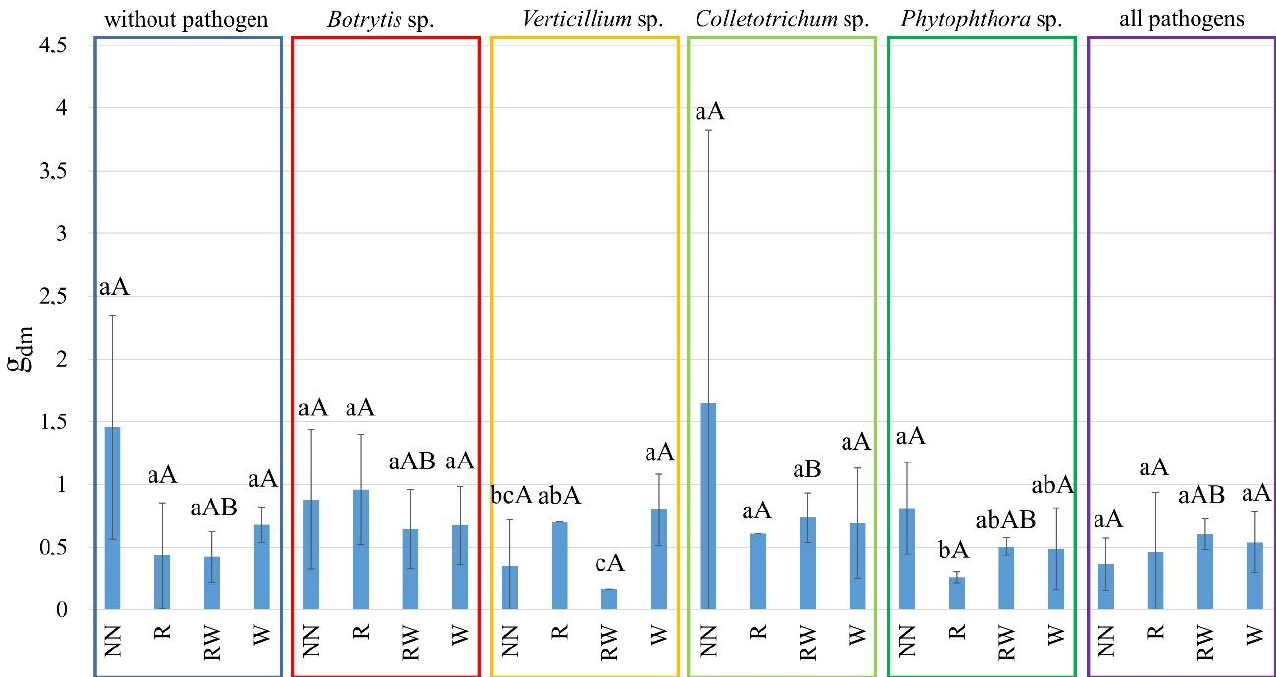
Figure 4. The early effect of the bacterial consortium on Polana raspberry plant growth in the pot experiment depended on the pathosystem and naturalization strategy applied. The wet biomass of the roots, according to pathosystems Botrytis cinerea , Verticillium sp., Colletotrichum acutatum , Phytophthora sp., and all pathogens ( Botrytis , Verticillium , Colletotrichum , Phytophthora ) and without pathogens, within different biopreparation application strategies: no naturalization (NN), root inoculations (R), root inoculations and watering (RW), and watering (W). The error bars indicate a standard deviation, n = 3, different lowercase letters above the bars indicate differences within the particular pathosystem, and different capital letters above the bars indicate differences within the particular naturalization strategies (according to ANOVA with p < 0.05).